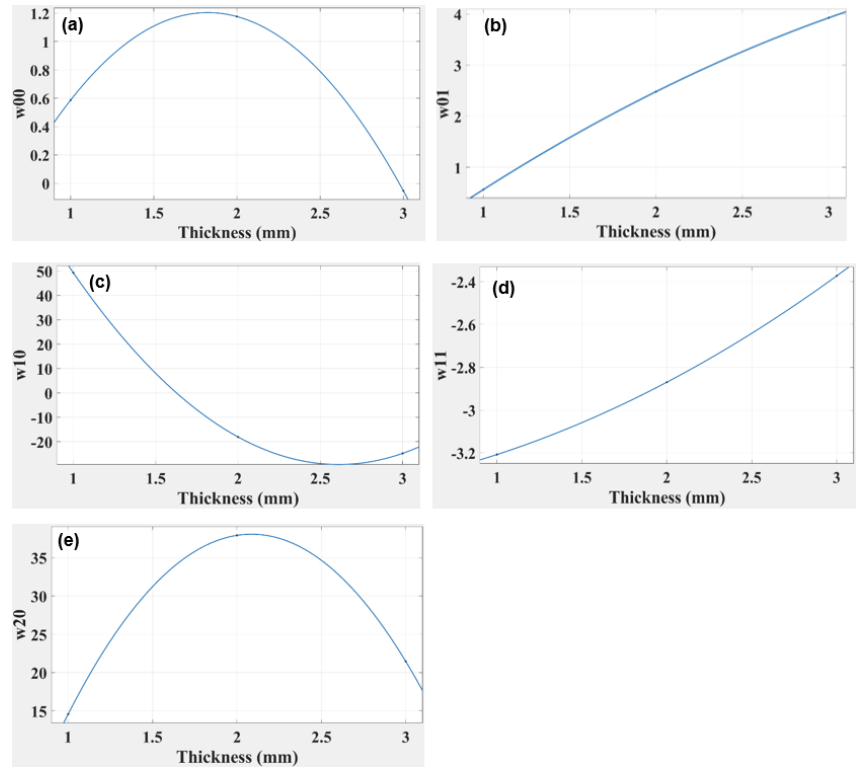
Figure 17. Graphs indicating the relationship of TPU “cross” beam thickness versus the coefficient for ( a ) w00 ( b ) w01 ( c ) w10 ( d ) w11 ( e ) w20 . for ( a ) w00 ( b ) w01 ( c ) w10 ( d ) w11 ( e )